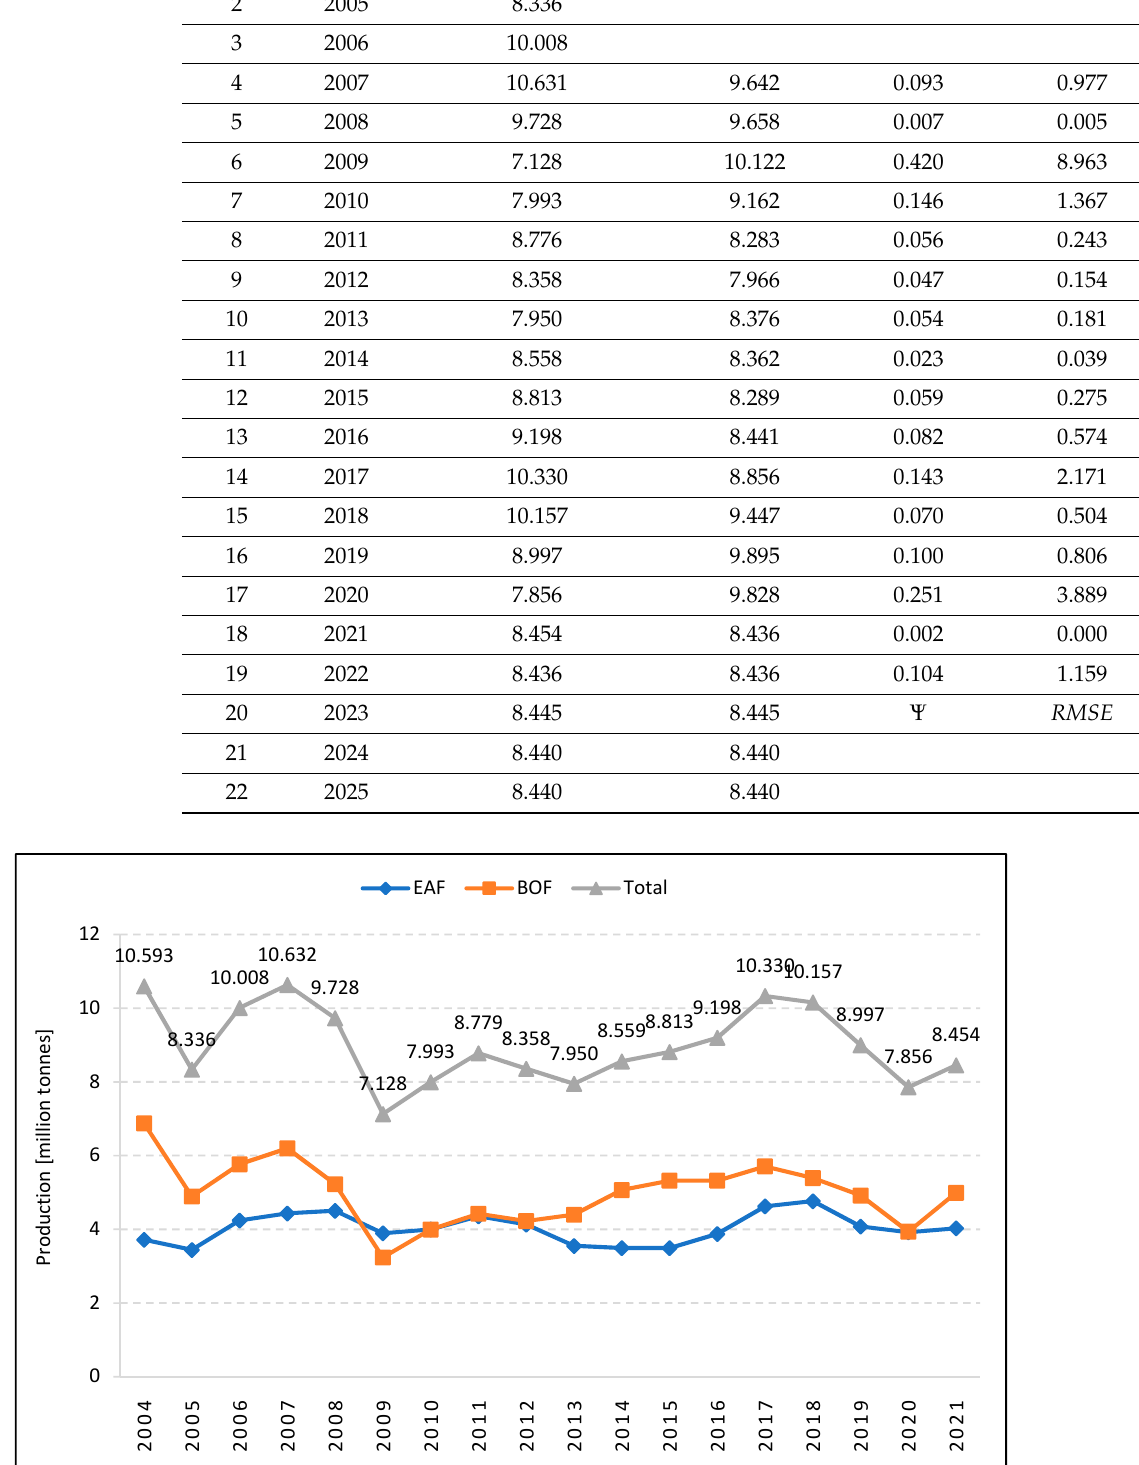
Figure 14. Steel production in Poland in the period: 2004–2021. Table 1. Forecasts of steel production in Poland.